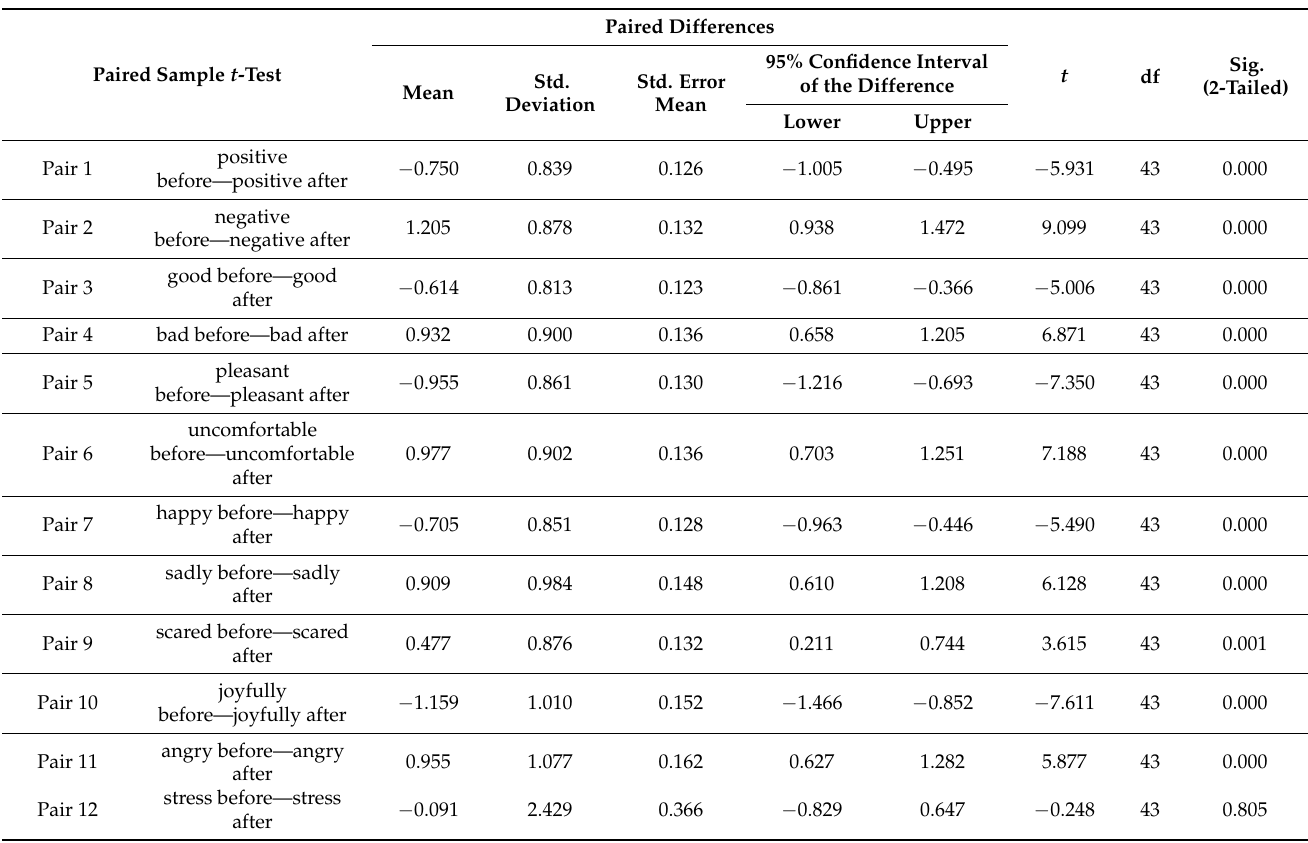
Table 5. The scale of positive and negative experience (SPANE) before and after the forest therapy experience display of paired